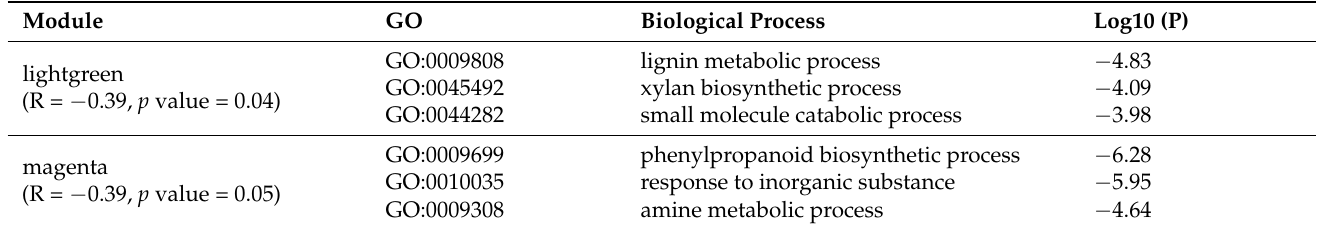
Table 2. Gene ontology terms enriched for biological processes using the Mg concentration associated modules DEGs in